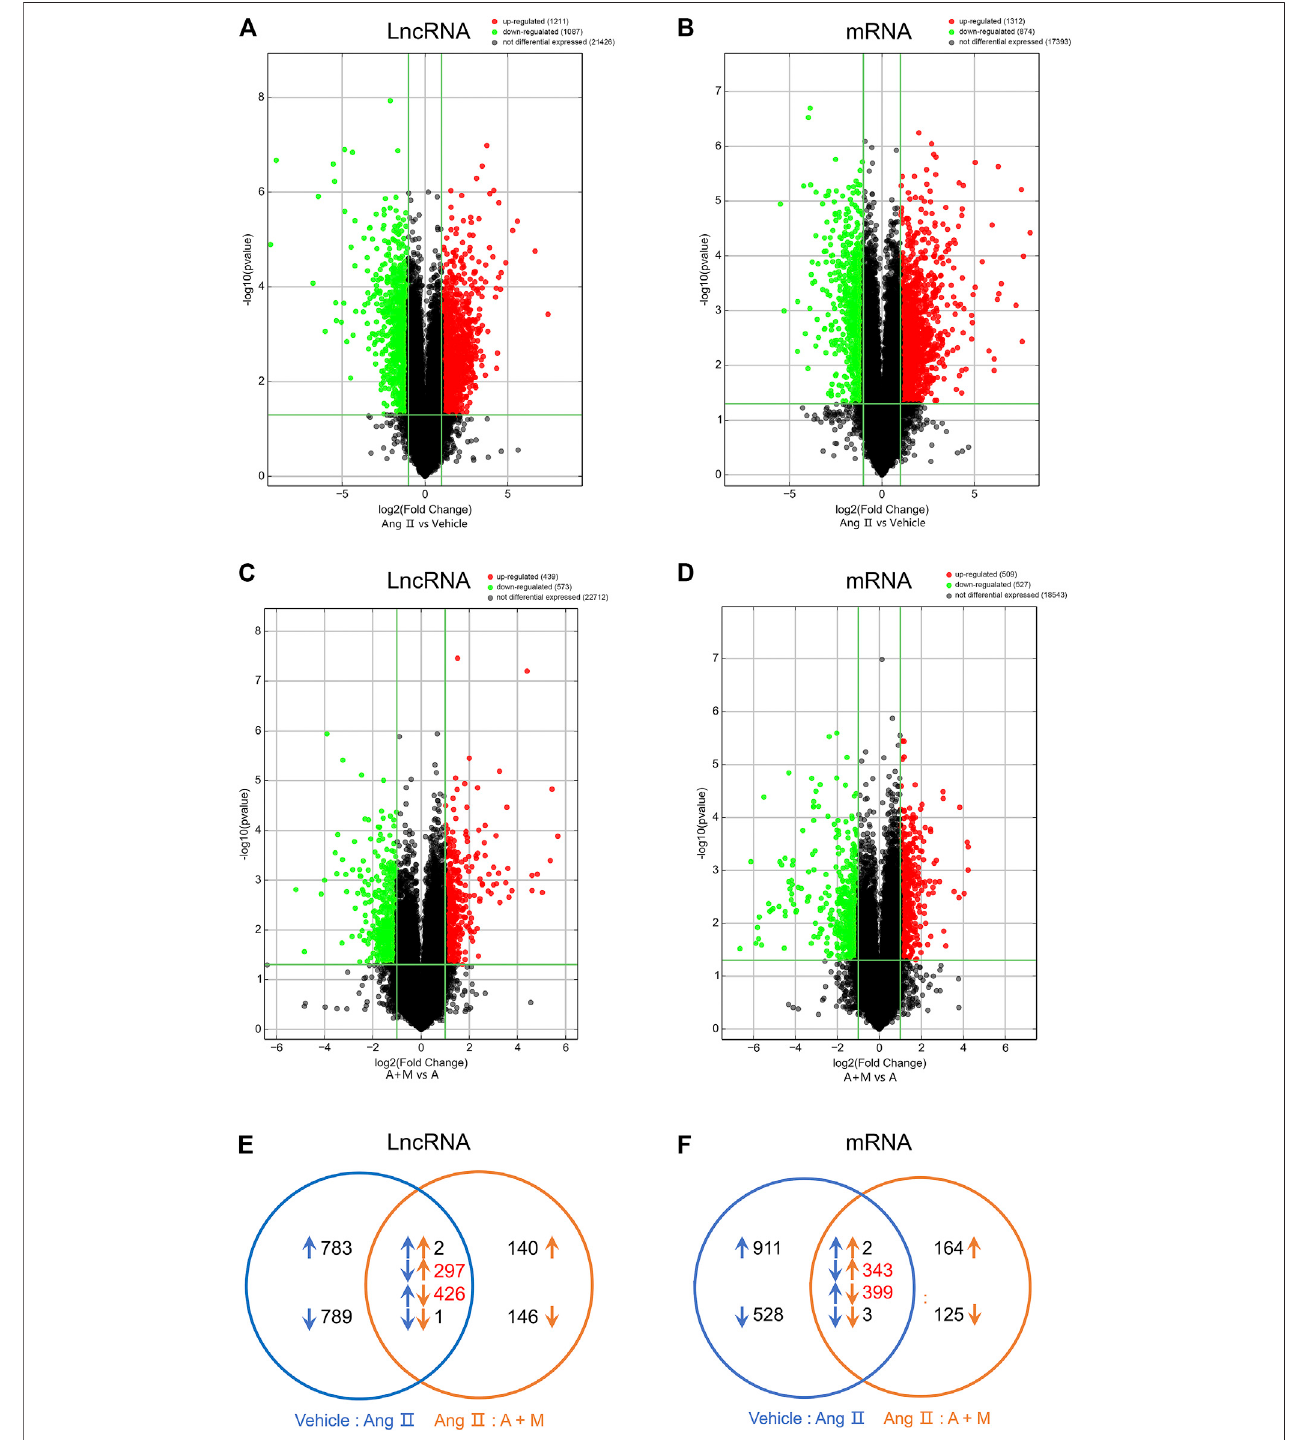
FIGURE2| MK-626regulatesexpressionpro fi lesoflncRNAsandmRNAs.VolcanoplotfordifferentiallyexpressedlncRNAsandmRNAsinAng Ⅱ groupcompared withVehicle (A – B) and A + M group compared with Ang Ⅱ group (C – D) . The red points represent upregulated genes; the green points represent downregulated genes; the black points represent unchanged genes. (E – F) A Venn diagram of differentially expressed lncRNAs and mRNAs in the mice. The comparison of A + M group and Ang Ⅱ group (orange arrows); the comparison of Ang Ⅱ group and Vehicle group (blue arrows); the upregulated genes (upward arrows); the downregulated genes (downward arrows); the number of genes regulated by MK-626 (red number). A + M, Ang Ⅱ + MK-626.